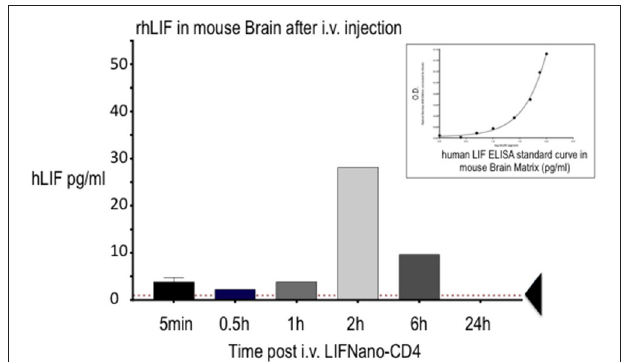
FIGURE 2 | Levels of rhLIF measured in the mouse brain following delivery of hLIFNano-CD4 to the mouse tail vein. Individual mice were culled at the indicated times and brain cryopreserved until analysis. Extracted samples were measured for hLIF levels by human-LIF-specific ELISA using a hLIF standard curve prepared in the mouse brain matrix (insert): note the effect of the matrix on the optical density (O.D.) readout contrasting to the standard linear readout when measured in diluent alone. Threshold of ELISA sensitivity is indicated by the